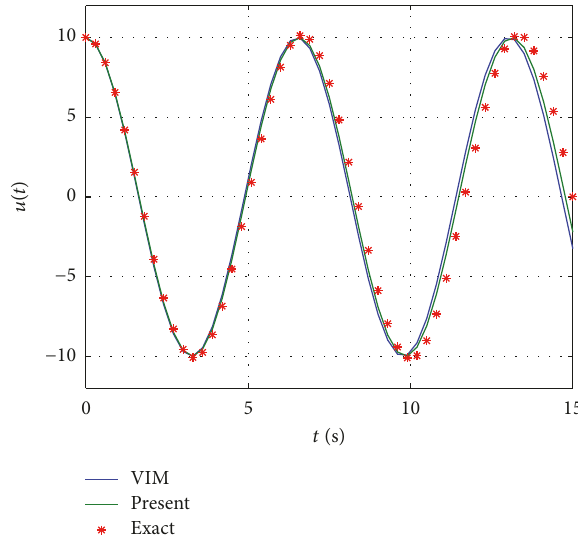
Figure 9: Comparison of time history diagram of displacement between the present, VIM, and exact solutions at 𝜂 = 0.7, 𝐴 = 10 , Example 3.